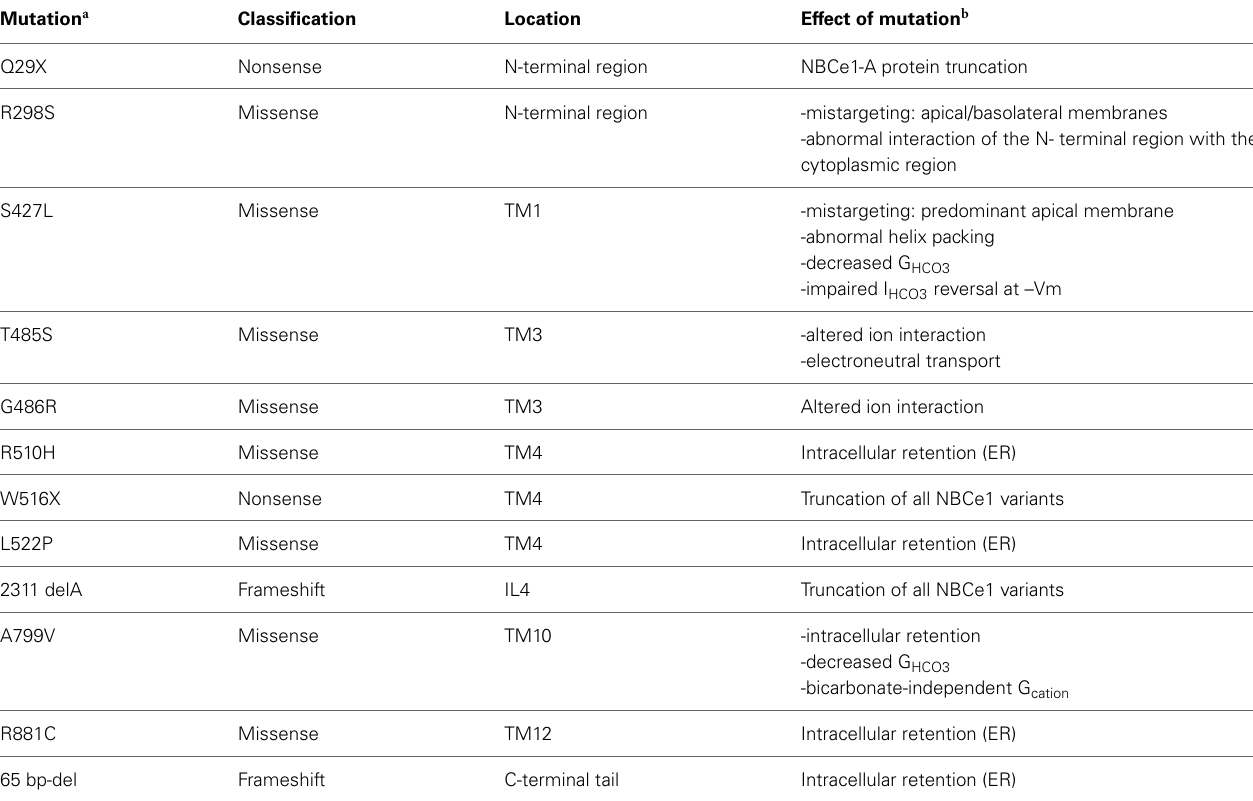
Table 1 | NBCe1-A pRTA causing